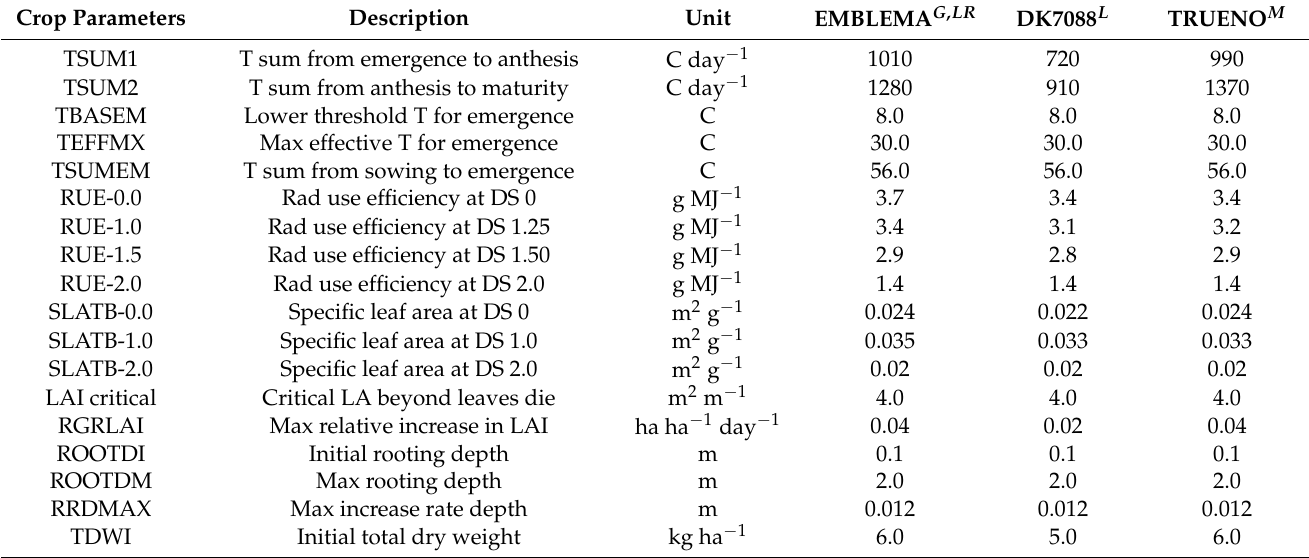
Table 3. Adjusted values for crop parameters calibration of the model. The variety EMBLEMA was used in Guayas (G) and Los Rios (LR), DK7088 was used in Loja (L), and TRUENO was used in Manabi (M). Crop